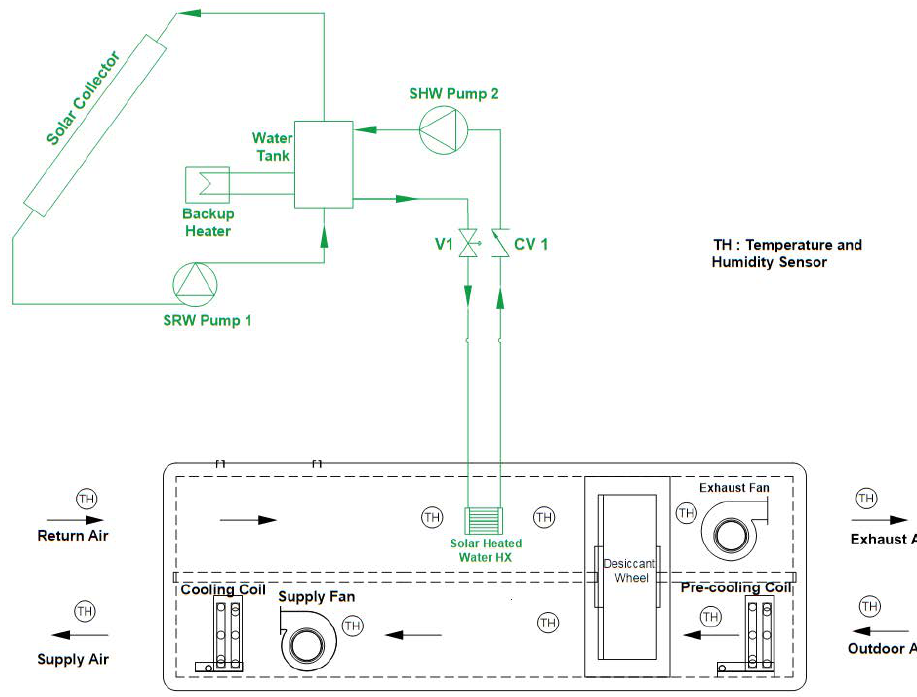
Figure 2. Solar-assisted SDCS configuration.